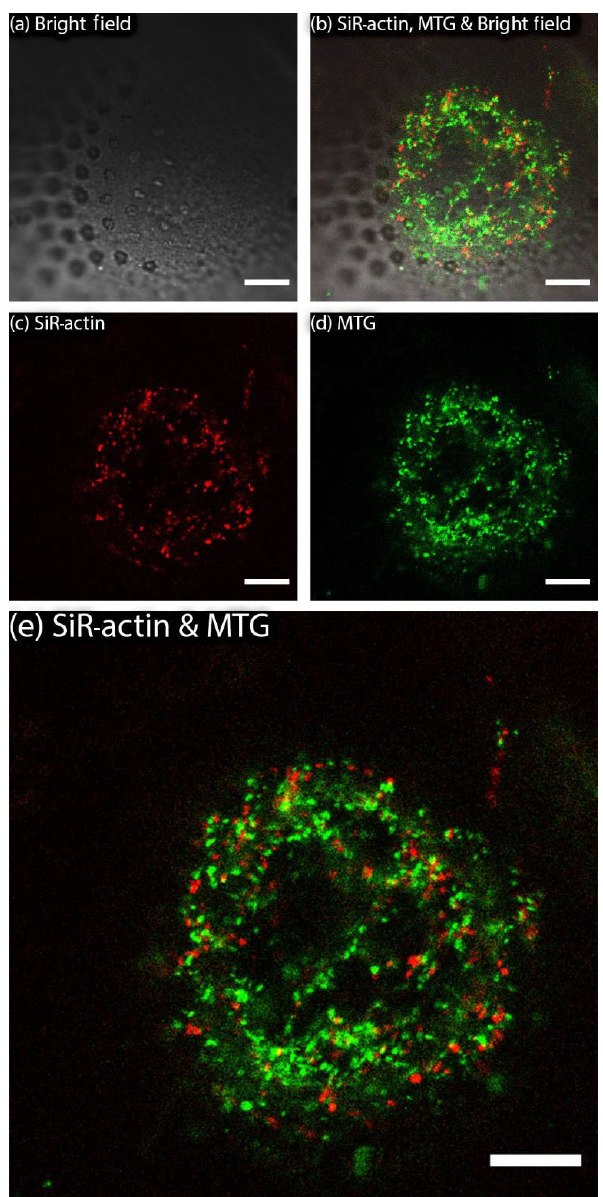
Figure 3. SiR-actin-labelled granules (ALGs) and mitochondria in cross section of a newly forming chamber in Amphistegina lessonii during biomineralisation (pores are already visible in transmitted light). ALGs and mitochondria do not show co-localisation. Images were obtained with Leica SP5 inverted confocal microscope (scale bar 10µm). For the entire time-lapse, see Movie S2.